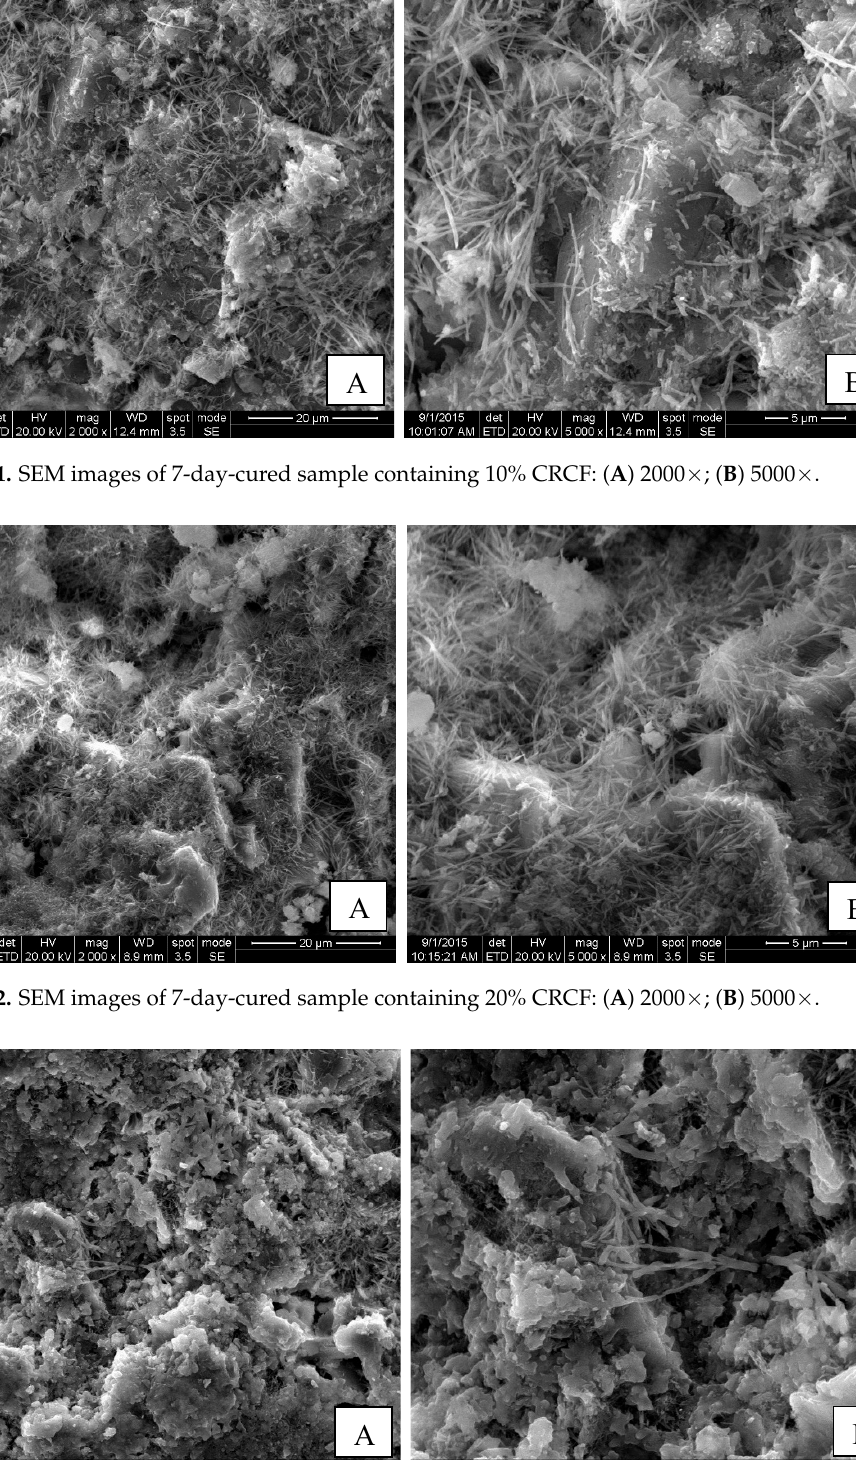
Figure 23. SEM images of 7-day-cured sample containing 30% CRCF: ( A ) 2000×; ( B ) 5000×.